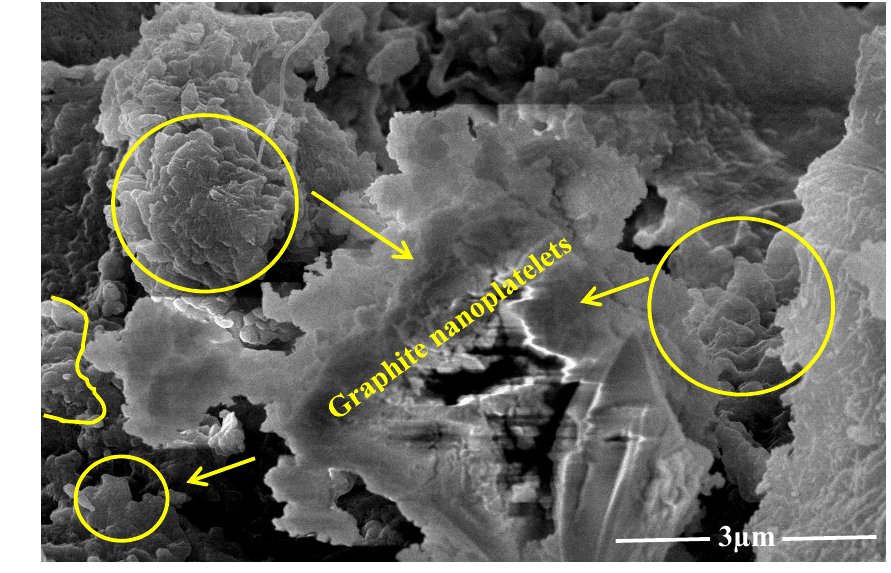
Figure 1. SEM image of exfoliated graphite. Table 3. Properties of MWCNTs.